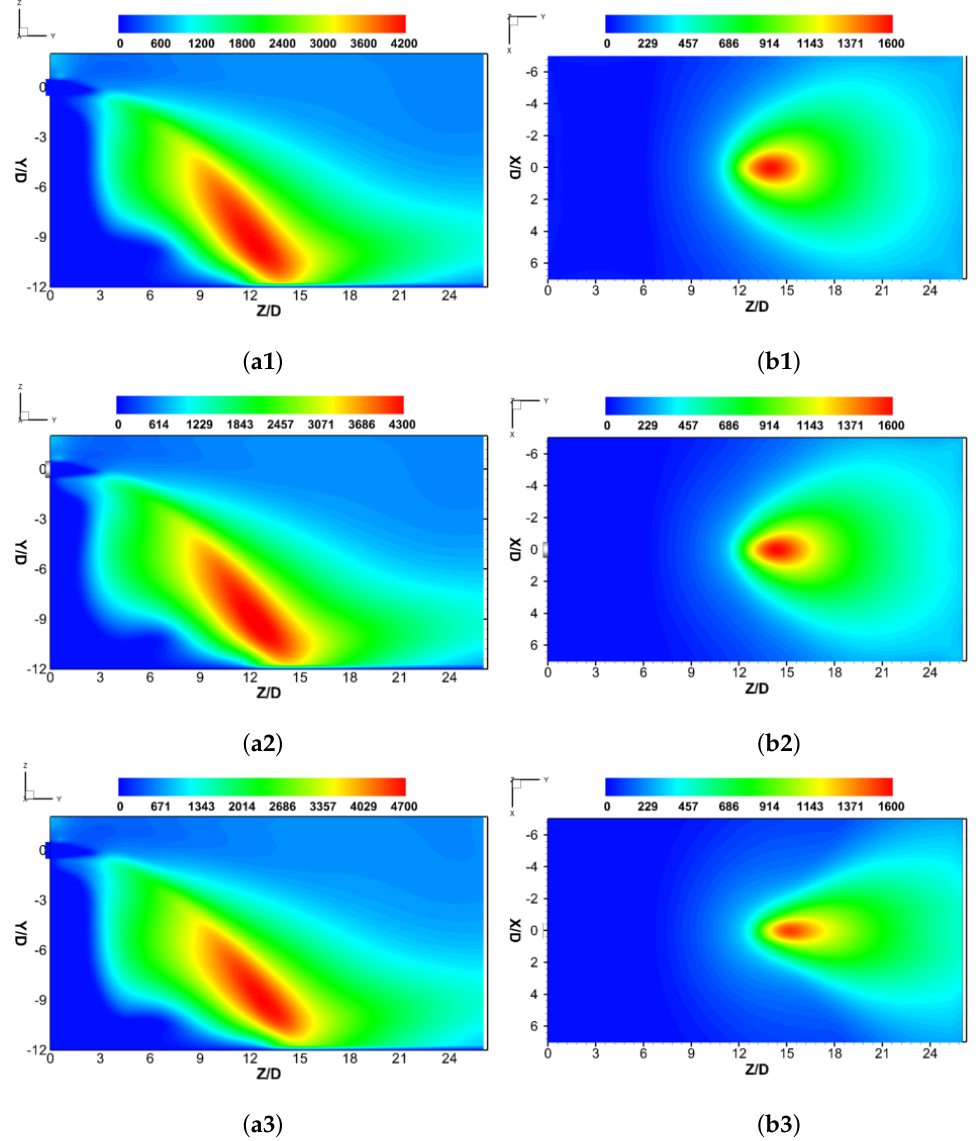
Figure 8. Contour plots of turbulent viscosity ratio in the Y-Z middle plane for Case-1 to Case-3 ( a1 – a3 ) and near the ground wall surface for Case-1 to Case-3 ( b1 – b3 ). Figure 9a shows the radial distribution of the solid volume fraction for various particle agents. The solid volume fraction is larger in the central region and less in the jet edge at both positions. When compared to the solid volume fraction predicted at Z / D = 14, the spreading increases radially, and consequently more solid particles agglomerate near the edge of the jet at Z / D = 18. The ABC dry powder (Case-1) and BC dry powder (Case-2) give a highest solid concentration at Z / D = 14, while more Portland cement powder